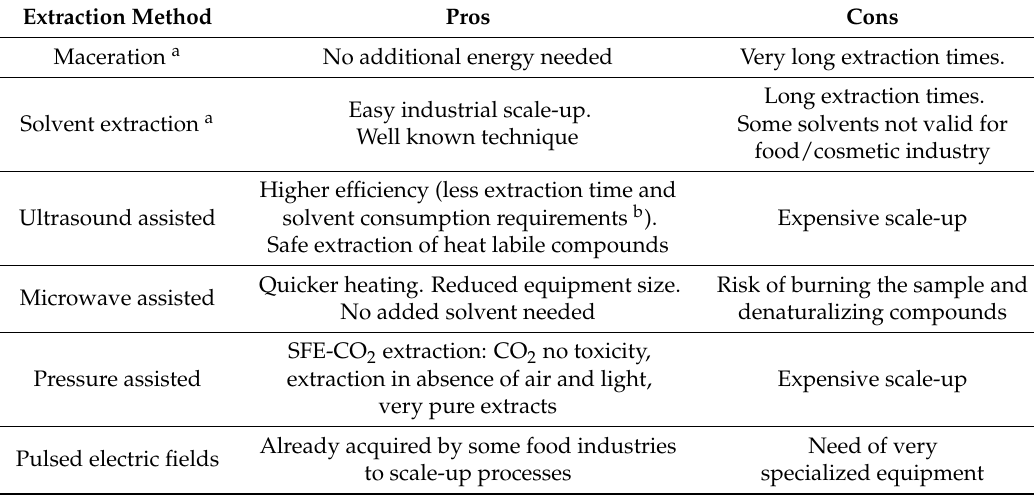
Table 3. Qualitative comparison of extraction methods